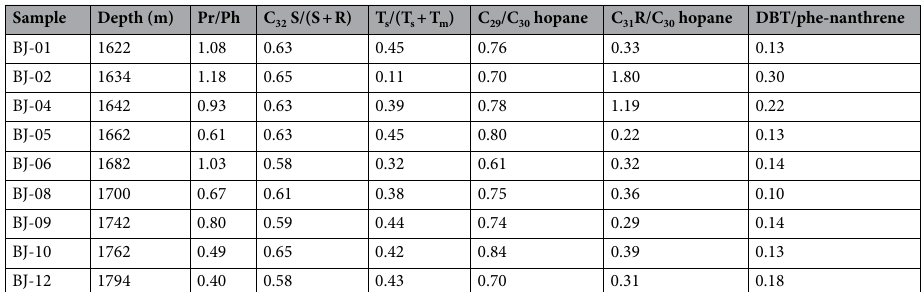
Table 4. Biomarker ratios from the Infracambrian rock sequence of Bijnot-1, (Pr/Ph: pristane/phytane; Ts/(Ts + Tm), 18α(H)-22,29,30-trisnorneohopane/(18α(H)-22,29,30-trisnorneohopane + 17α(H)- 22,29,30-trisnorhopane); C 32 S/(S + R), C 32 hopane, 22S/(22S + 22R), C 29 /C 30 hopane: 17α(H),21β(H)-C 29 hopane/17α(H),